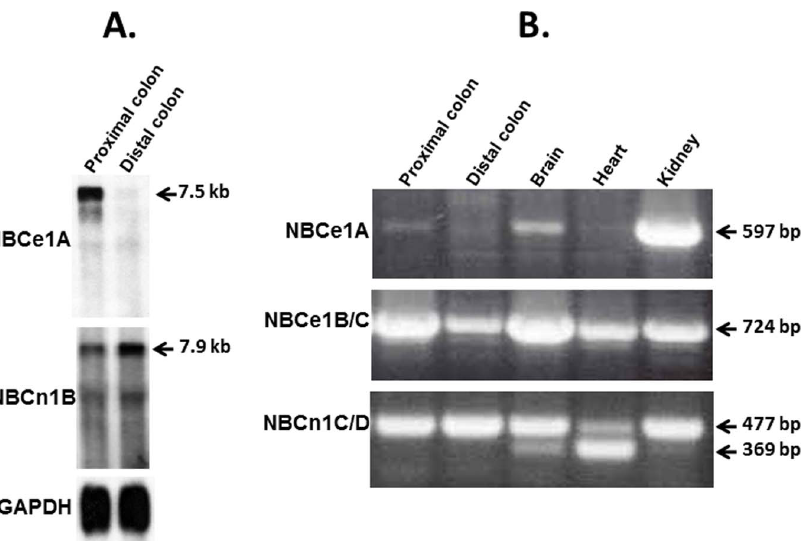
Figure 2. Northern blot and RT-PCR analyses of mRNA from rat colon. [ A ] Northern blot analyses indicate that NBCe1A (7.5 kb)-like mRNA is predominantly expressed in proximal colon, while NBCn1B (7.9 kb)-like mRNA is expressed in both proximal and distal colon. Full length NBCe1A and NBCn1A cDNAs were used as probe. The blots were also probed with a GAPDH cDNA fragment. Results presented are from an individual blot that was stripped and probed sequentially with each probe (NBCe1A, NBCn1A and GAPDH). [ B ] RT-PCR analyses indicate that NBCe1B/C and NBCn1C/D specific transcripts are predominantly expressed in epithelial cells from proximal and distal colon. NBC isoform specific fragments were amplified by RT-PCR using isoform specific primers (Table 2) and mRNA from proximal colon, distal colon, brain, heart and kidney. RT-PCR products were separated on 1% agarose gels and stained with ethidium bromide. cDNA size markers are indicated on the right side.